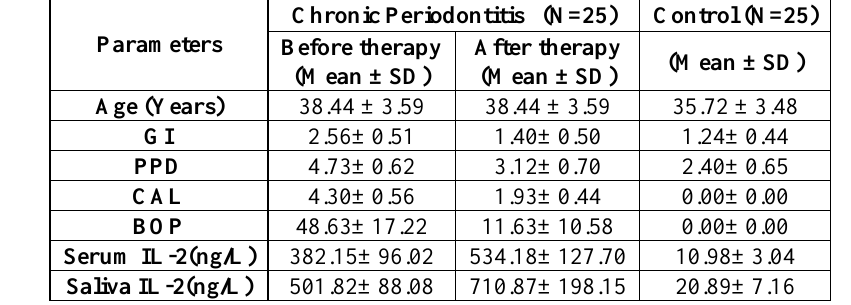
Table 1: The descriptive statistics (mean± SD) for age, GI, BOP, PPD, CAL, serum and salivary IL-2 Levels in control and study group before and after non-surgical periodontal therapy